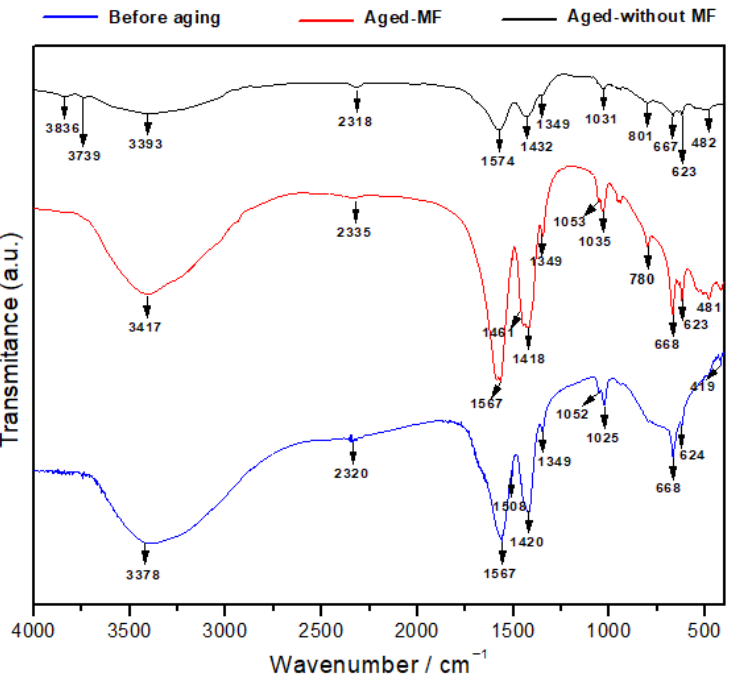
Figure 3. FTIR spectra for the samples as prepared: aging under MF and aging under no MF at room temperature.